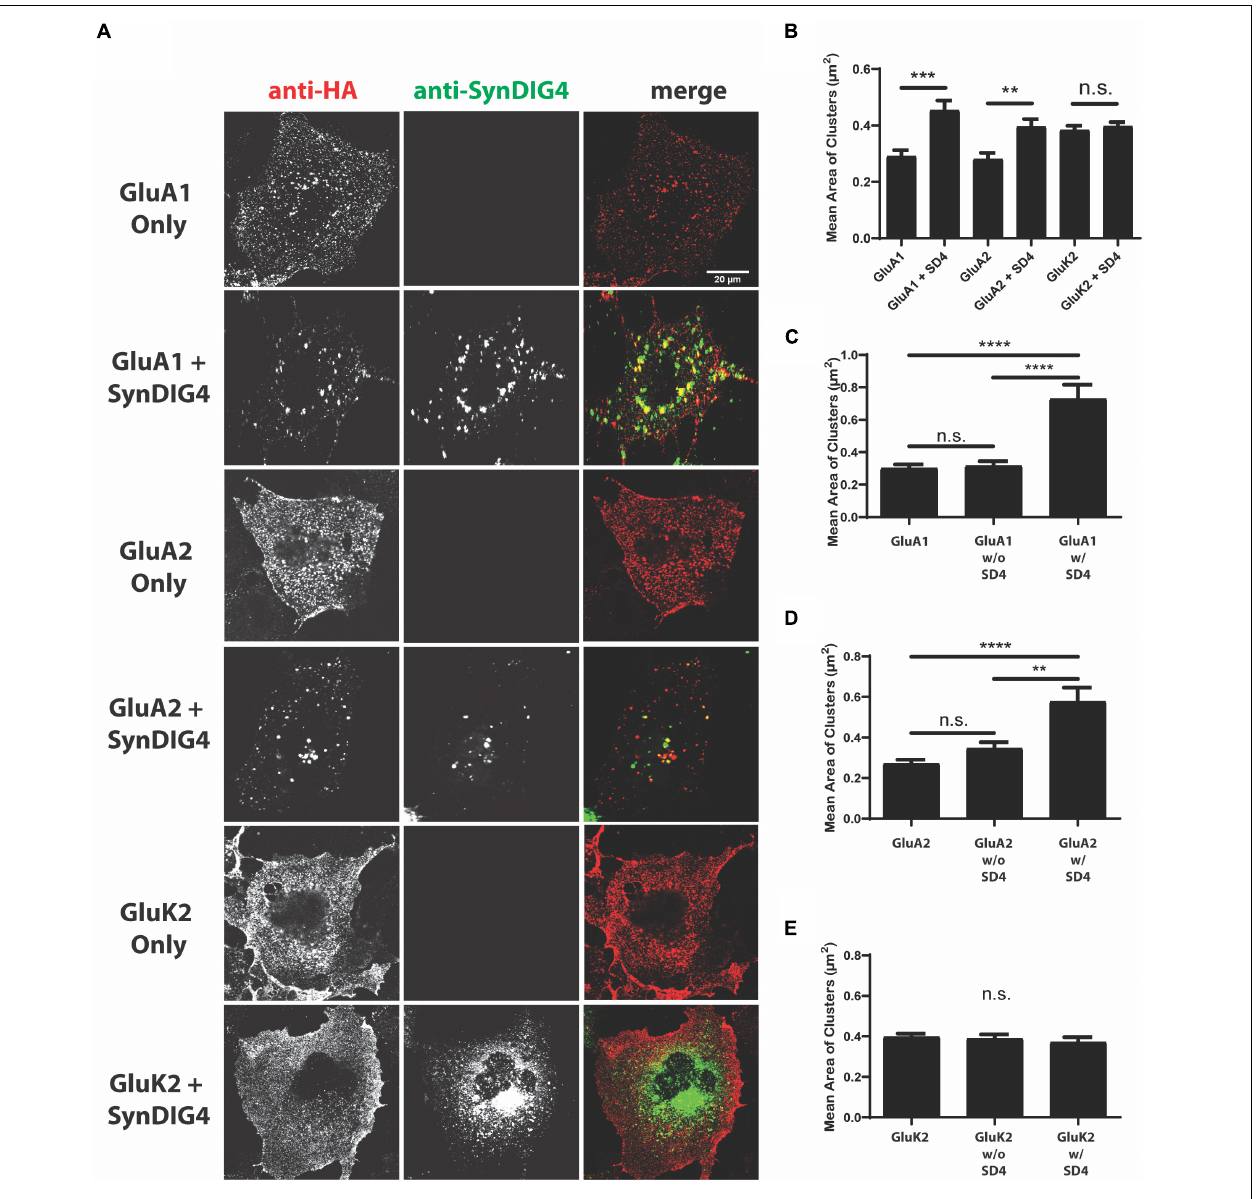
FIGURE 1 | Synapse differentiation-induced gene 4 (SD4) clusters GluA1 and GluA2-containing α -amino-3-hydroxy-5-methyl-4-isoxazolepropionic acid receptors (AMPARs). (A) Representative confocal images of COS cells transfected with either receptor alone, or co-transfected with both receptor and SD4. Cells were live labeled with anti-hemagglutinin (HA) antibodies against surface expressing receptors and anti-SD4 antibodies for total SD4. Scale bar = 20 µ m. (B) Graph depicts the mean cluster size of GluA1 alone ( n = 10), GluA1 + SD4 ( n = 12), GluA2 alone ( n = 16), GluA2 + SD4 ( n = 10), GluK2 alone ( n = 13), or GluK2 + SD4 ( n = 11) puncta. (C–E) Graphs depict the stratification of GluA1 (C) , GluA2 (D) , or GluK2 (E) puncta either co-localized or not co-localized with SD4 compared with the average cluster size of receptor alone. Data are represented as mean cluster size ± SEM; n.s. not significant; ** p < 0.01; *** p < 0.001; and **** p < 0.0001; one-way ANOVA with post-hoc Tukey’s